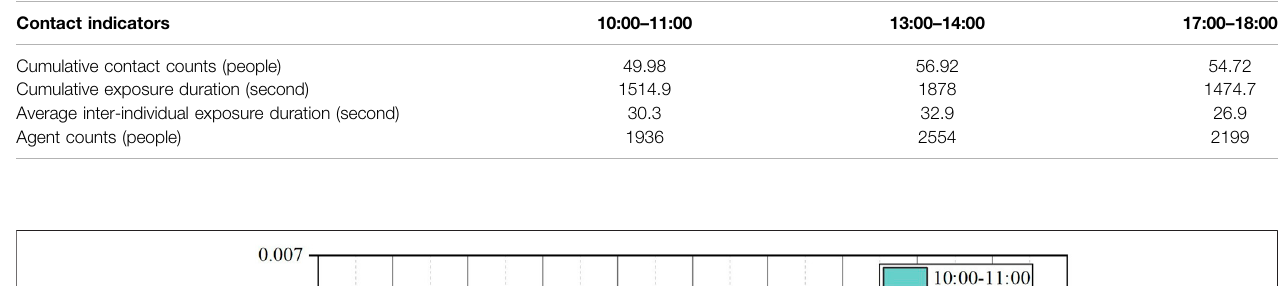
Frontiers in Physics |